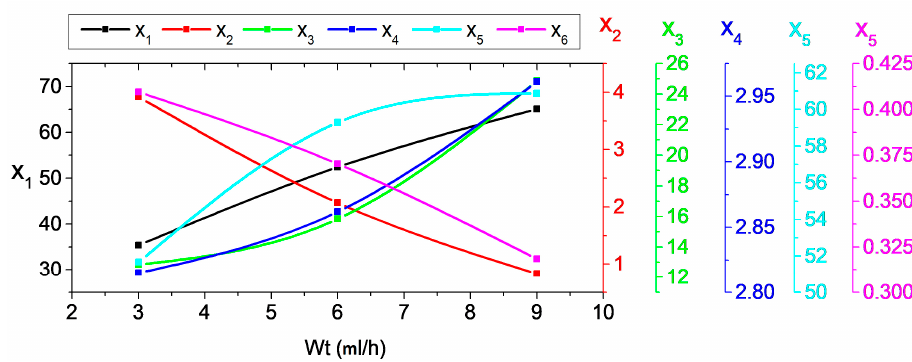
Figure 12. The impact of Wt on indicators shift.